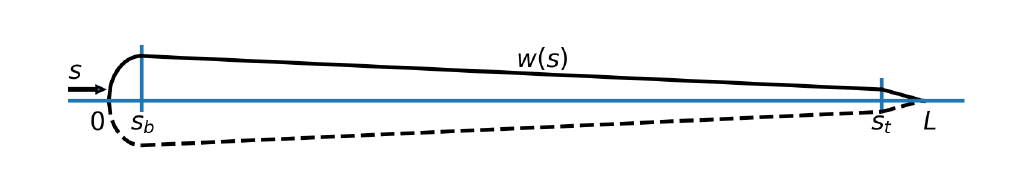
Figure 1. Parametrization of the swimmer surface as described in Equation